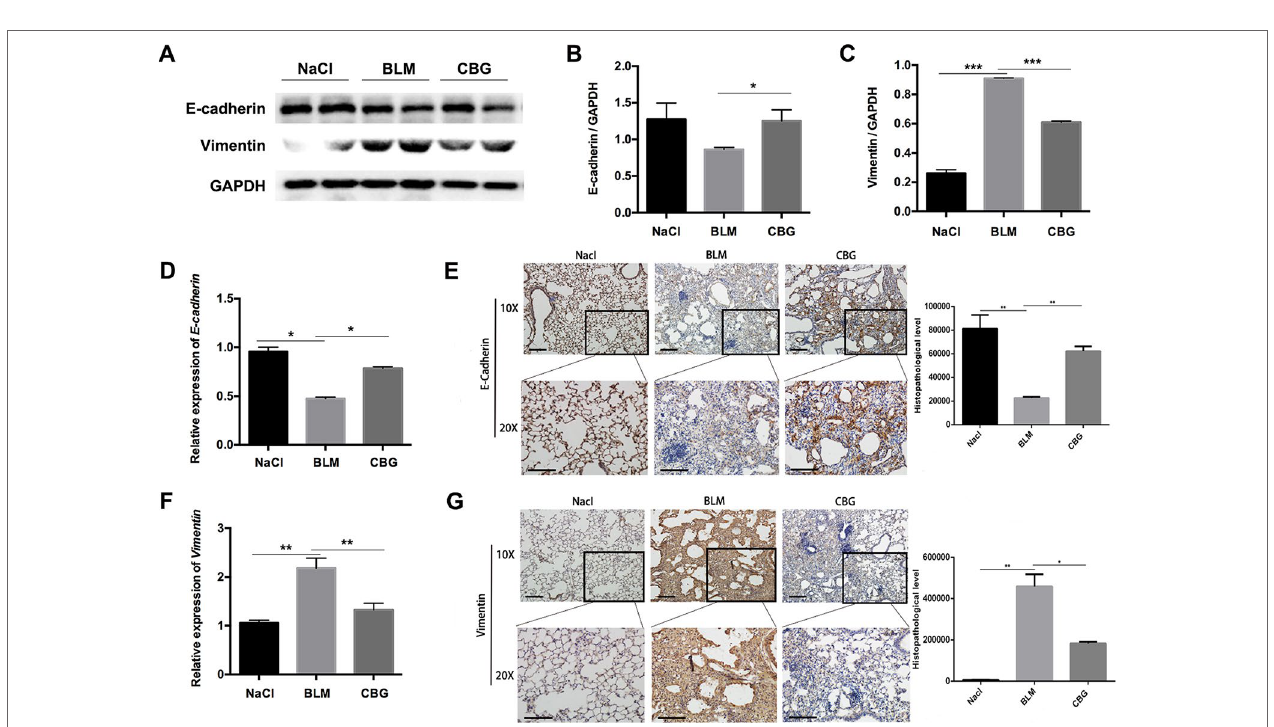
FIGURE 9 | Cinobufagin represses EMT in vivo . (A) Western blot was used to analyze the protein levels of E-cadherin and Vimentin in lung tissues. (B, C) Densitometric analysis of E-cadherin and Vimentin in immunoblots using GAPDH as the internal reference. (D, F) Real-time PCR was performed to detect the mRNA levels of E-cadherin and Vimentin in the pulmonary tissues derived from each group. (E, G) Immunohistochemical staining of E-cadherin and Vimentin-positive cells in the lungs. Data are expressed as the means ± SD (n = 6), *P < 0.05; **P < 0.01; ***P <